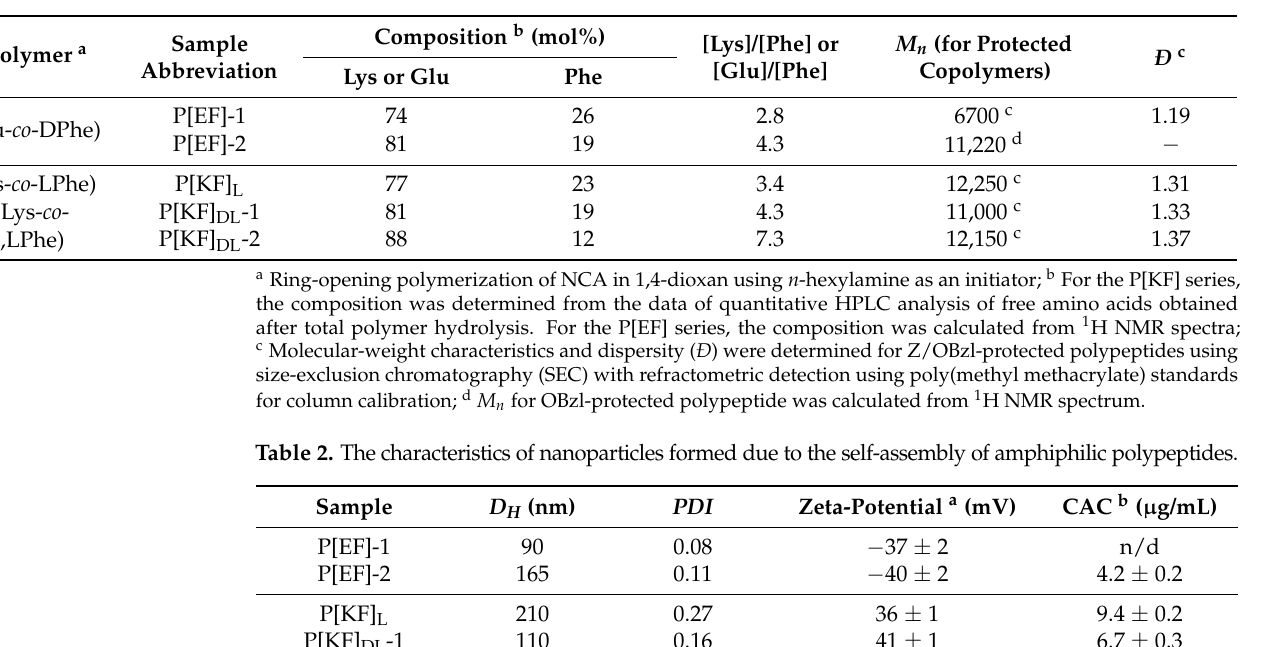
Table 1. Characteristics of amphiphilic polypeptides used as carriers for conjugation with DEX.